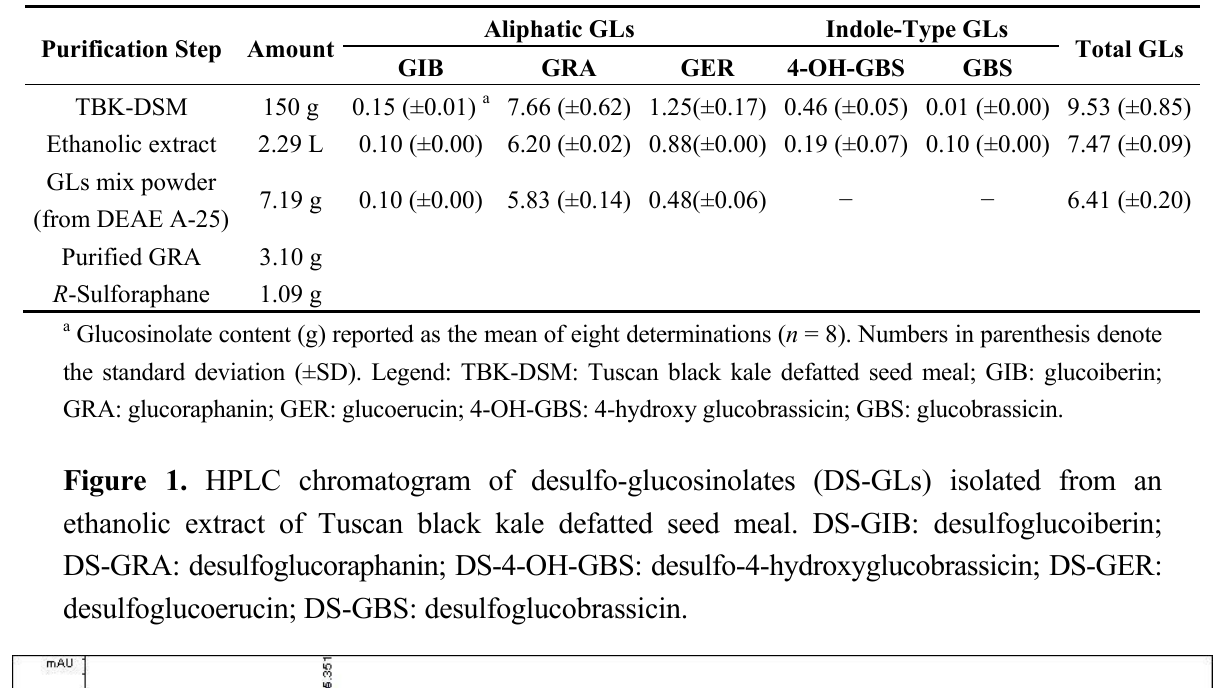
Table 1. Summary of data for the purification of glucoraphanin (GRA) and the production of R -sulforaphane starting from 150 g of Tuscan black kale ( Brassica oleracea (L.) ssp acephala (DC) var. Sabellica L. cv. 0D74) defatted seed meal.